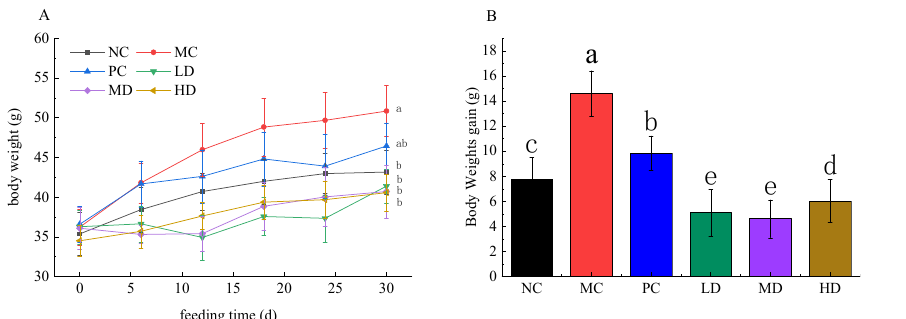
Figure 2. Body weight changes, body weight gain in mice fed experimental diets for 30 days. ( A ) Body weight changes; ( B ) body weight gain. Values are displayed as a bar chart plot with means (expressed as ‘+’), n = 3. a–e: bars with different letters are significantly different at p < 0.05 by Tukey’s post hoc test. NC: normal group (normal feed, 0.9% saline); MC: model group (HFD, 0.9% saline); PC: positive group (HFD, 0.5 mg/mL xuezhikang capsules); LD: RFV low dose group (HFD, 10% RFV); MD: RFV medium dose group (HFD, 30% of RFV); HD: RFV high dose group (HFD, 50% of RFV).